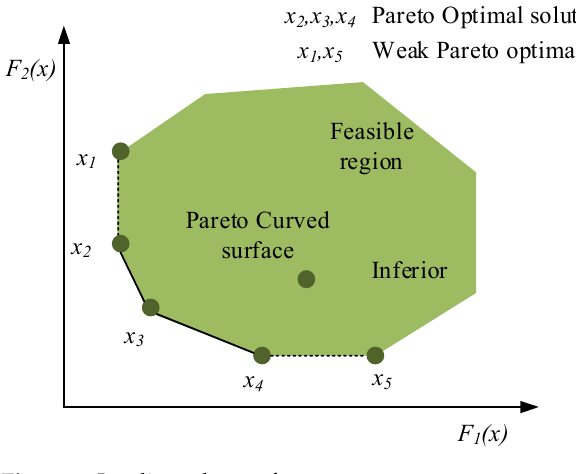
Figure 3. Leading edge surface.